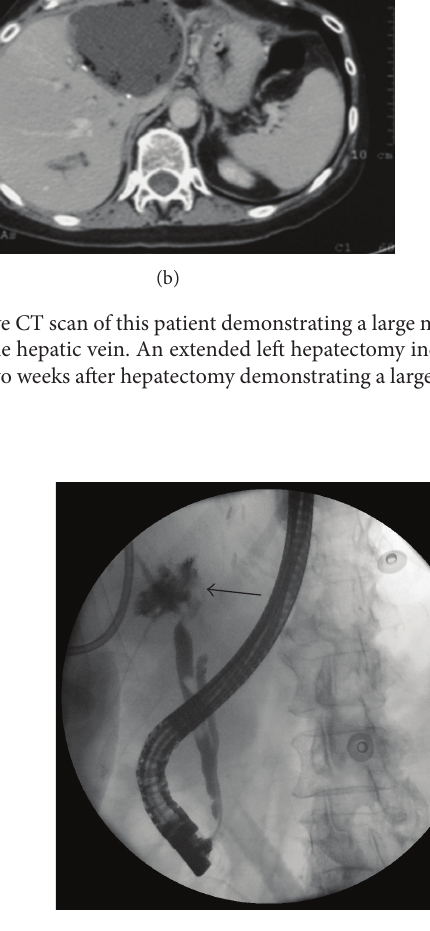
Figure 3: Post-hepatectomy ERCP. Post-hepatectomy ERCP dem- onstrating extravasation of contrast (black arrow) from the conflu- ence of the right hepatic duct and left hepatic duct